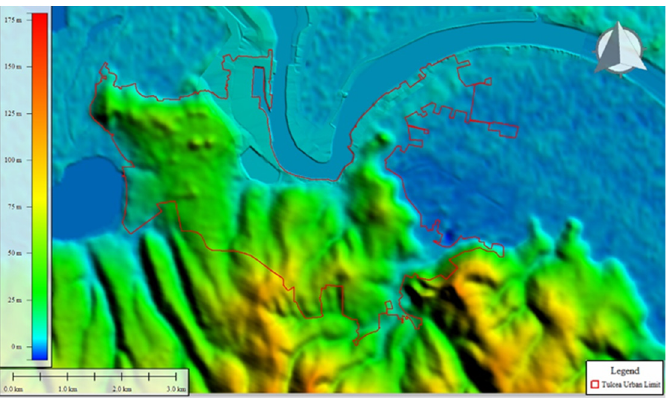
Figure 2. Administrative limits of the Tulcea municipality and the corresponding DEM.